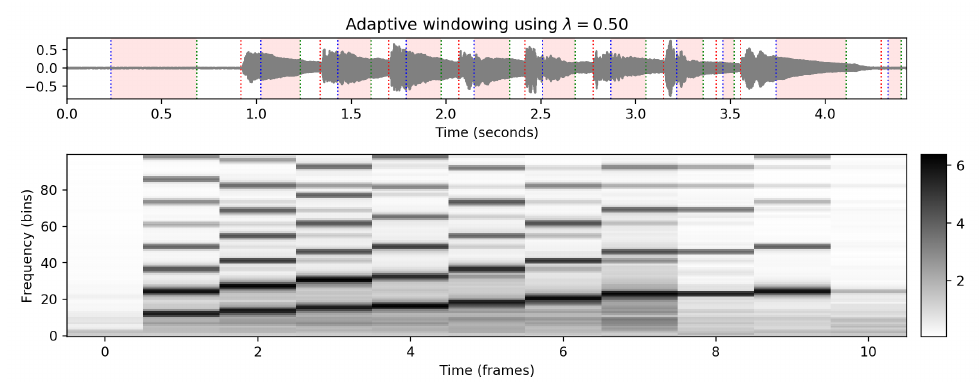
Figure 17. Example of adaptive windowing using a parameter λ ∈ R to control the neighborhood’s relative size to be excluded. ( Top ): Waveform and nonuniform time grid (indicated by red verti- cal lines). ( Bottom ): Adaptive feature representation (obtained from a spectrogram) with frames corresponding to the shaded segments of the